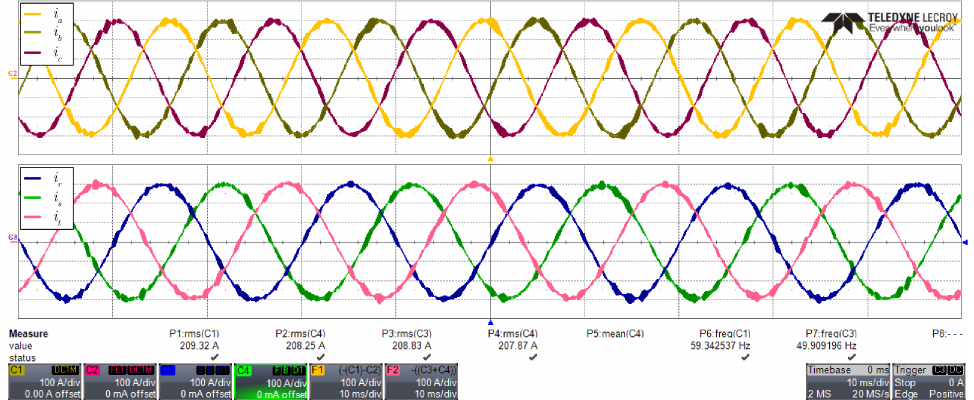
Figure 8. Hexverter line currents in both ports, where the 209 A rms value is measured in both ports, with a frequency of 60 Hz in port 1 and 50 Hz in port 2.